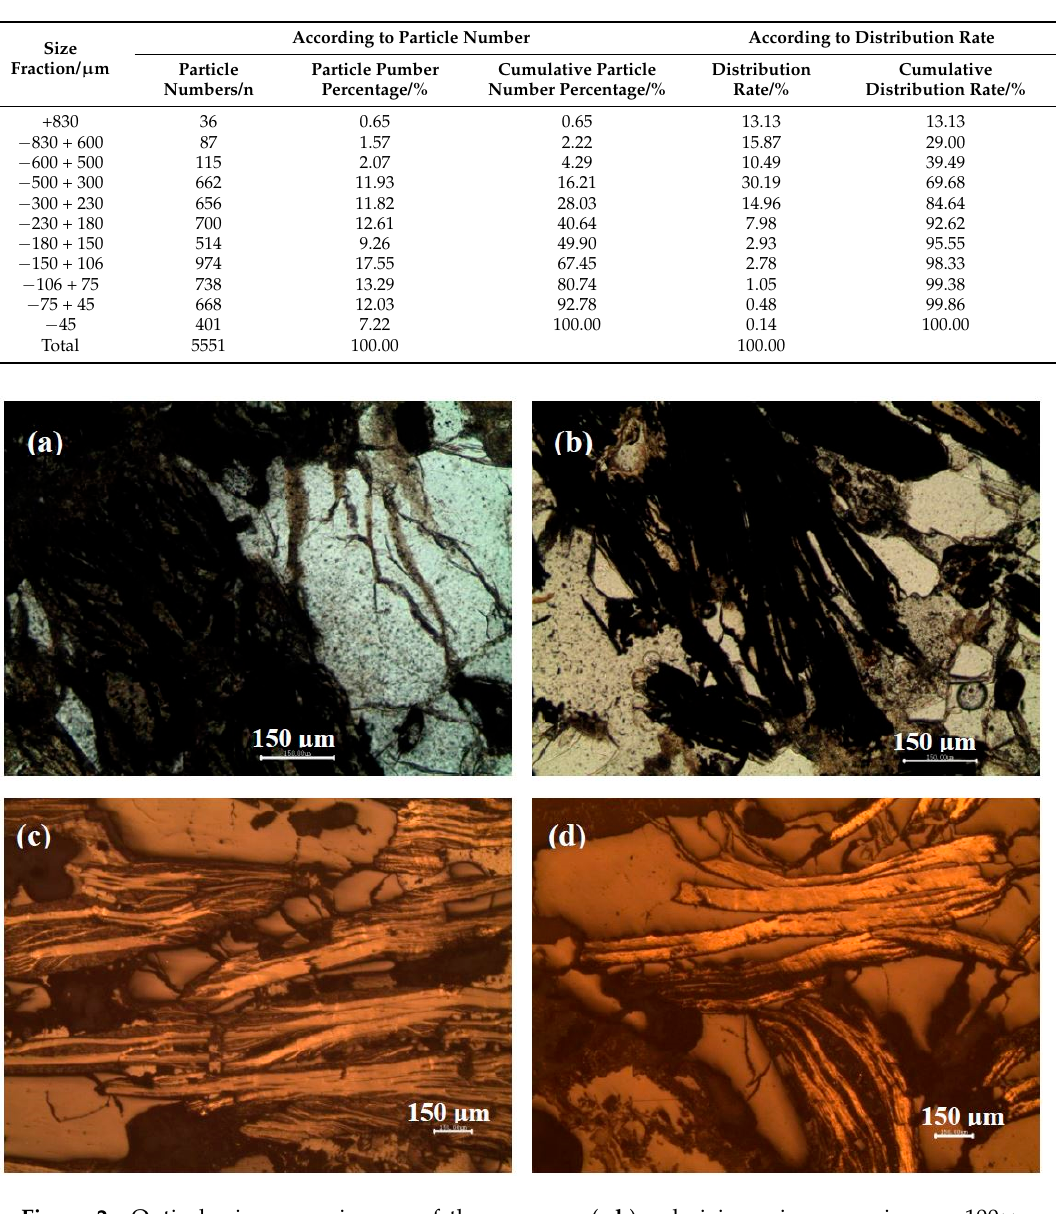
Table 4. Liberation characteristics of the graphite flakes.